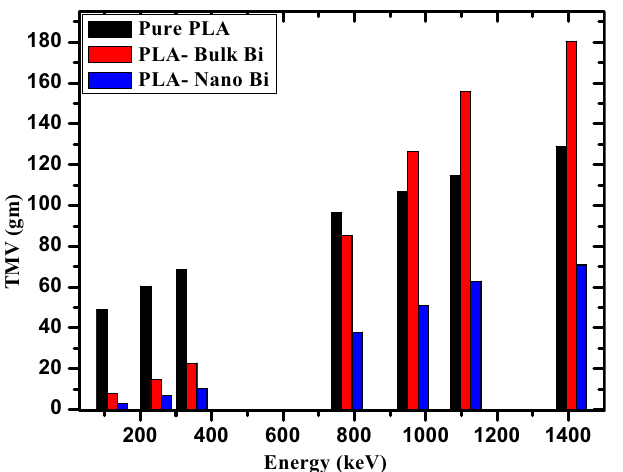
Figure 7. The TMV for the pure PLA, PLA with bulk Bi, and PLA with nano Bi at different